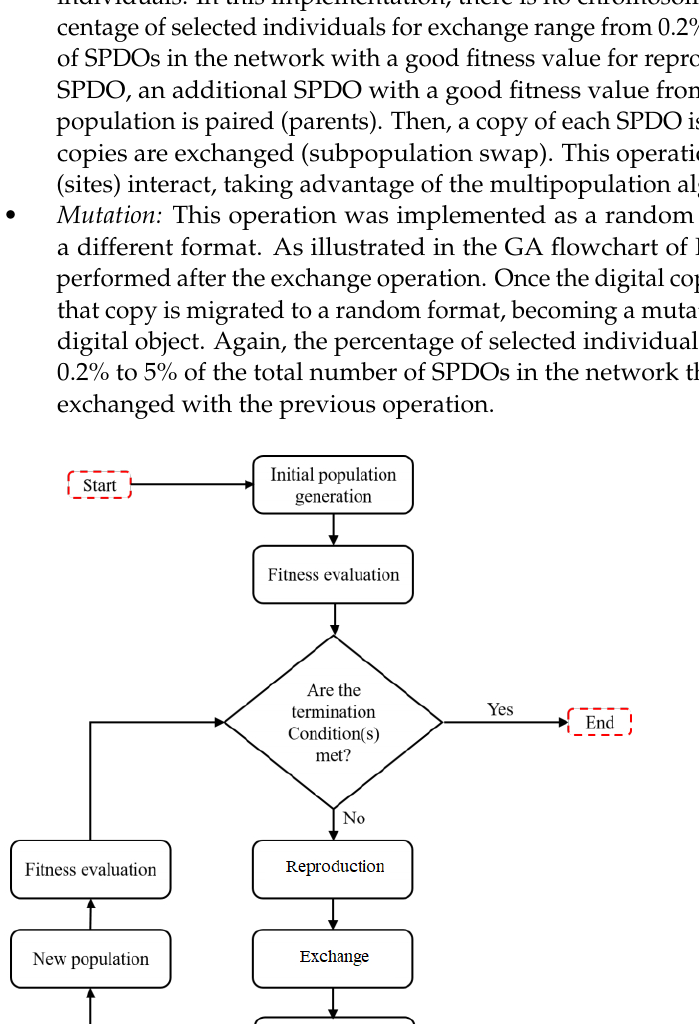
Figure 1, the algorithm starts by generating random populations of SPDOs in every site (subpopulation). After fitness evaluation of all individuals (or just a selection, depending on the method), the next population of children is obtained by combining two selected parents using the next operators: